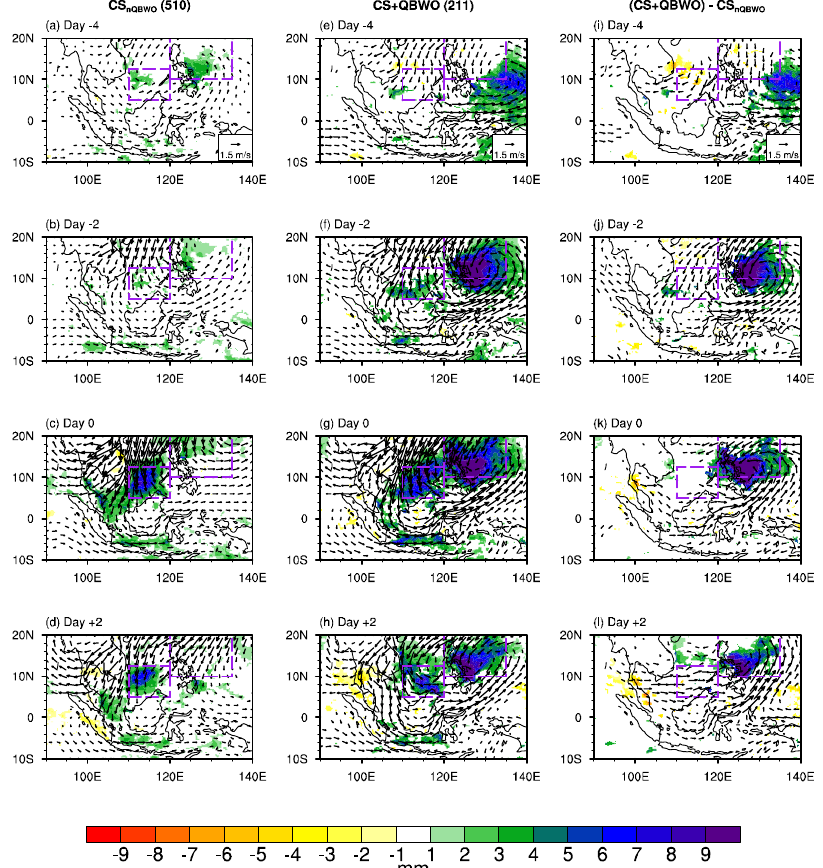
Figure 6. Composite daily evolution of precipitation (shade, SI = 1 mm) and 925 hPa wind (vectors, unit: 1.5 ms −1 ) anomalies during cold surge days ( a – d ) without and ( e – h ) with active QBWO days on ( a , e ) day −4, ( b , f ) day −2, ( c , g ) day 0 and ( d , h ) day +2, respectively. ( i – l ) are the differences between the days when cold surges and the QBWO co-exist and the days of cold surge without the QBWO. Rectangles represent the regions over the EPH (10°–20°N, 120°–135°E) and NBO (5°–12.5°N, 110°–120°E), respectively. Number in the top indicates the composite days. Values and vectors exceeding the 95% confidence levels based on the two−tailed Student's t −test are shown.